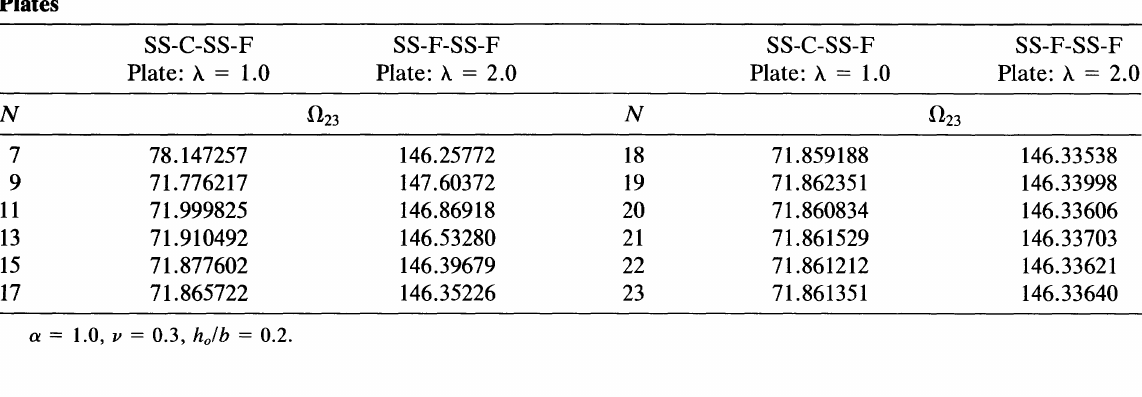
Table 3. Semianalytical DQ Solution with Equally Spaced Sampling Points for Thick Isotropic